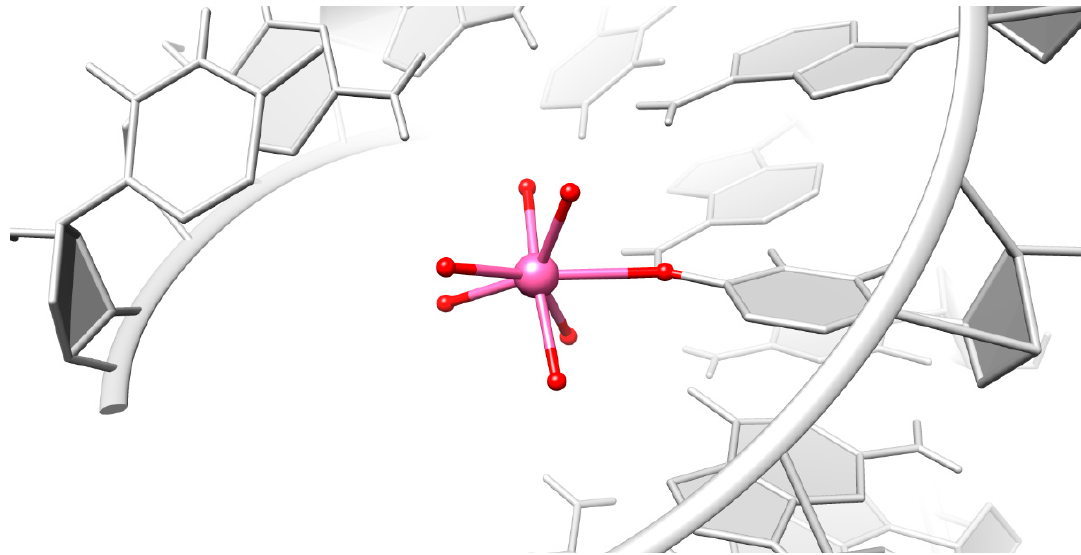
Figure 4. The unique innersphere interaction of Co 2+ (pink sphere) to O4 of uracil with six additional coordinated water molecules (red spheres).